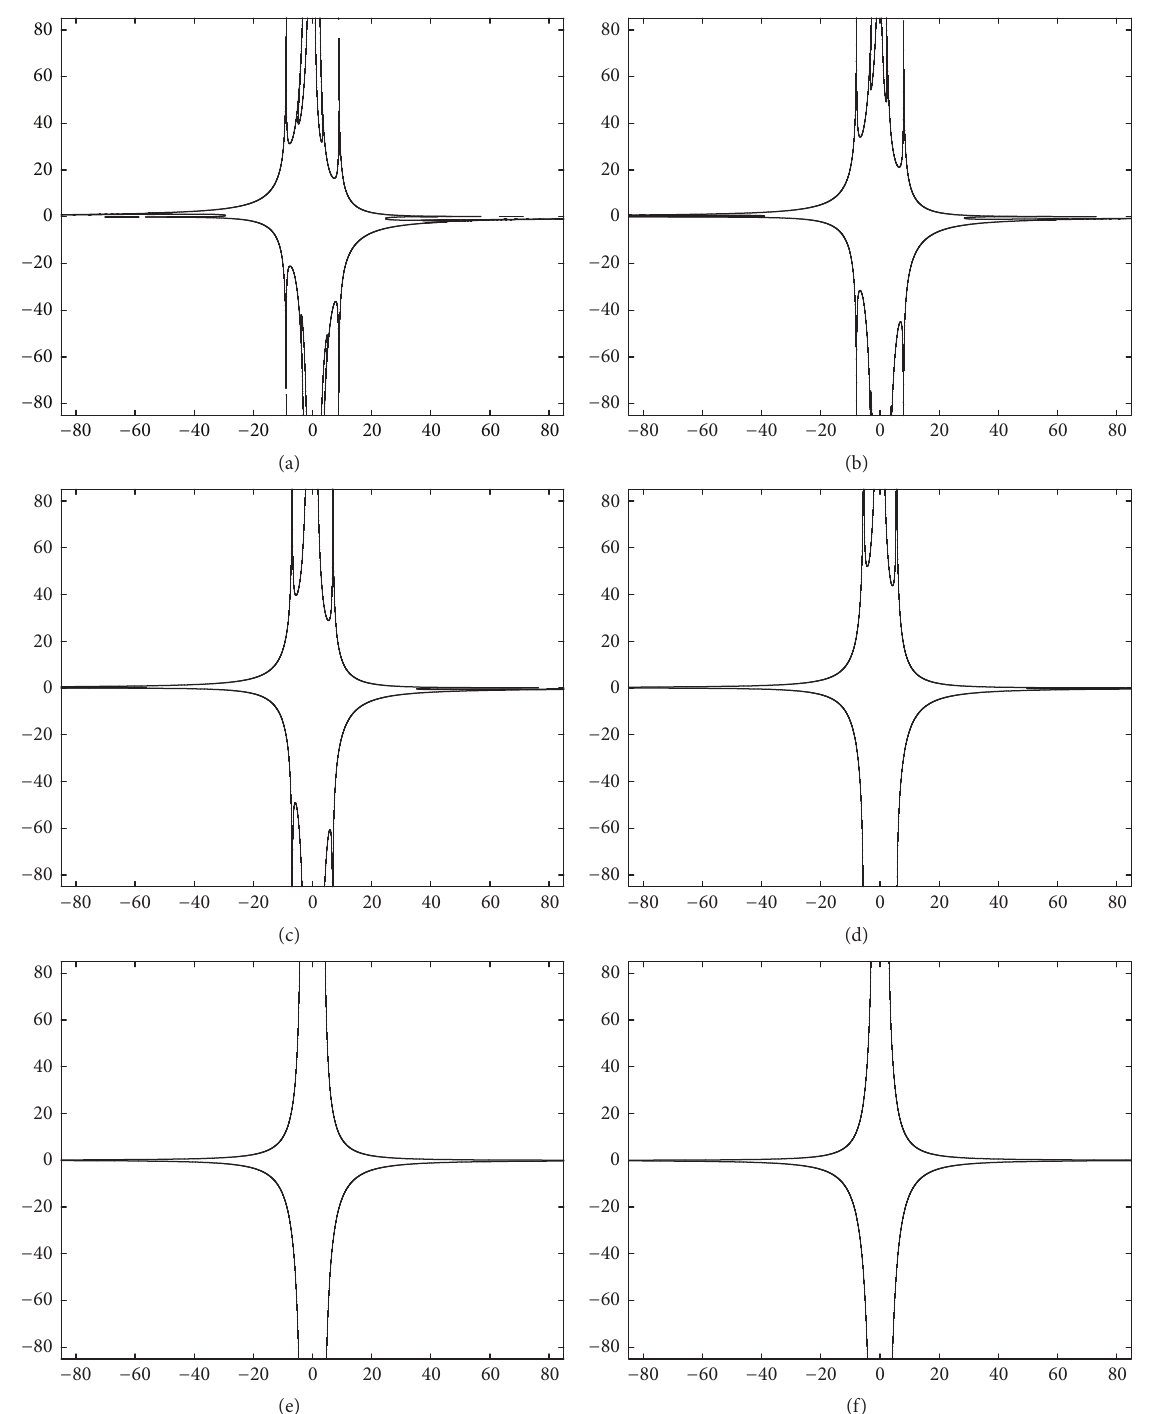
Figure 4: The change of the Julia sets of the controlled system when 𝑎 = 0.07, 𝑏 = 0.02 , and 𝛾 = 0.01 . (a) 𝑘 = −0.22 ; (b) 𝑘 = −0.38 ; (c) 𝑘 = −0.54 ; (d) 𝑘 = −0.70 ; (e) 𝑘 = −0.86 ; (f) 𝑘 = −1 .